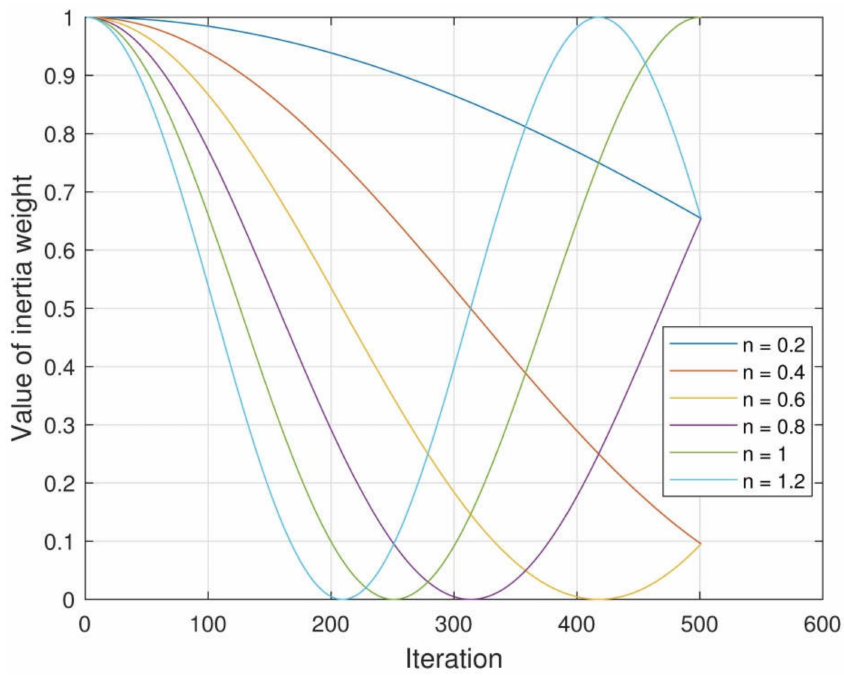
Figure 3. Nonlinear weight with diverse values n